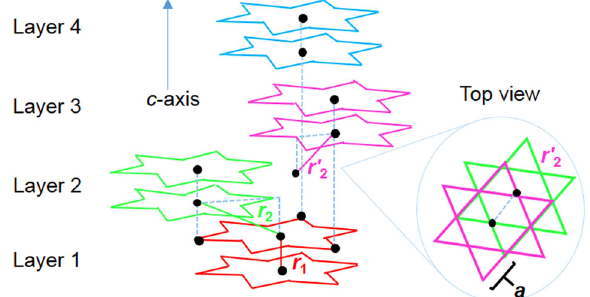
Fig. 3 CDW structure and interplane stacking in 1T-TaS 2 . The lattice parameter a = 3.36 Å is depicted in the top view. In the case of the repetitive stacking with the nearest-neighbor distances r 1 = 5.90 Å and r 2 = 8.29 Å only double layers one and two alternate while the screw stacking with the nearest-neighbor distances r 1 and r ′ Å is formed by double layers one to